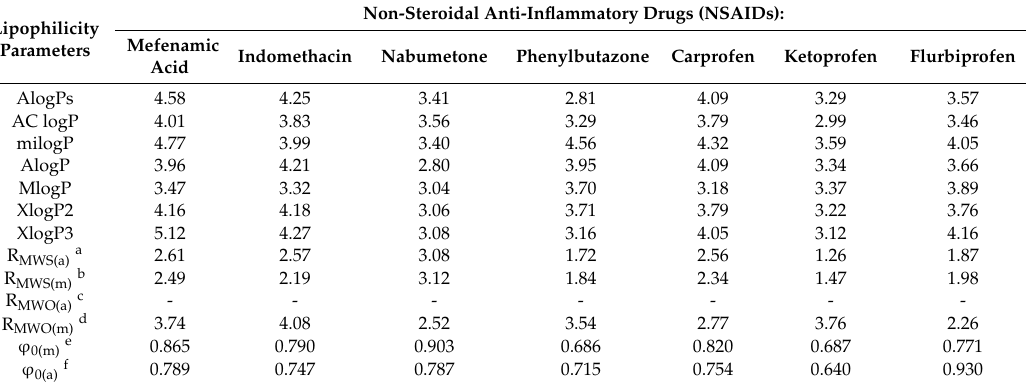
Table 3. Summary of the lipophilicity study of NSAIDs by using the theoretical and RP-TLC methods. Non-Steroidal Anti-Inflammatory Drugs Lipophilicity Parameters